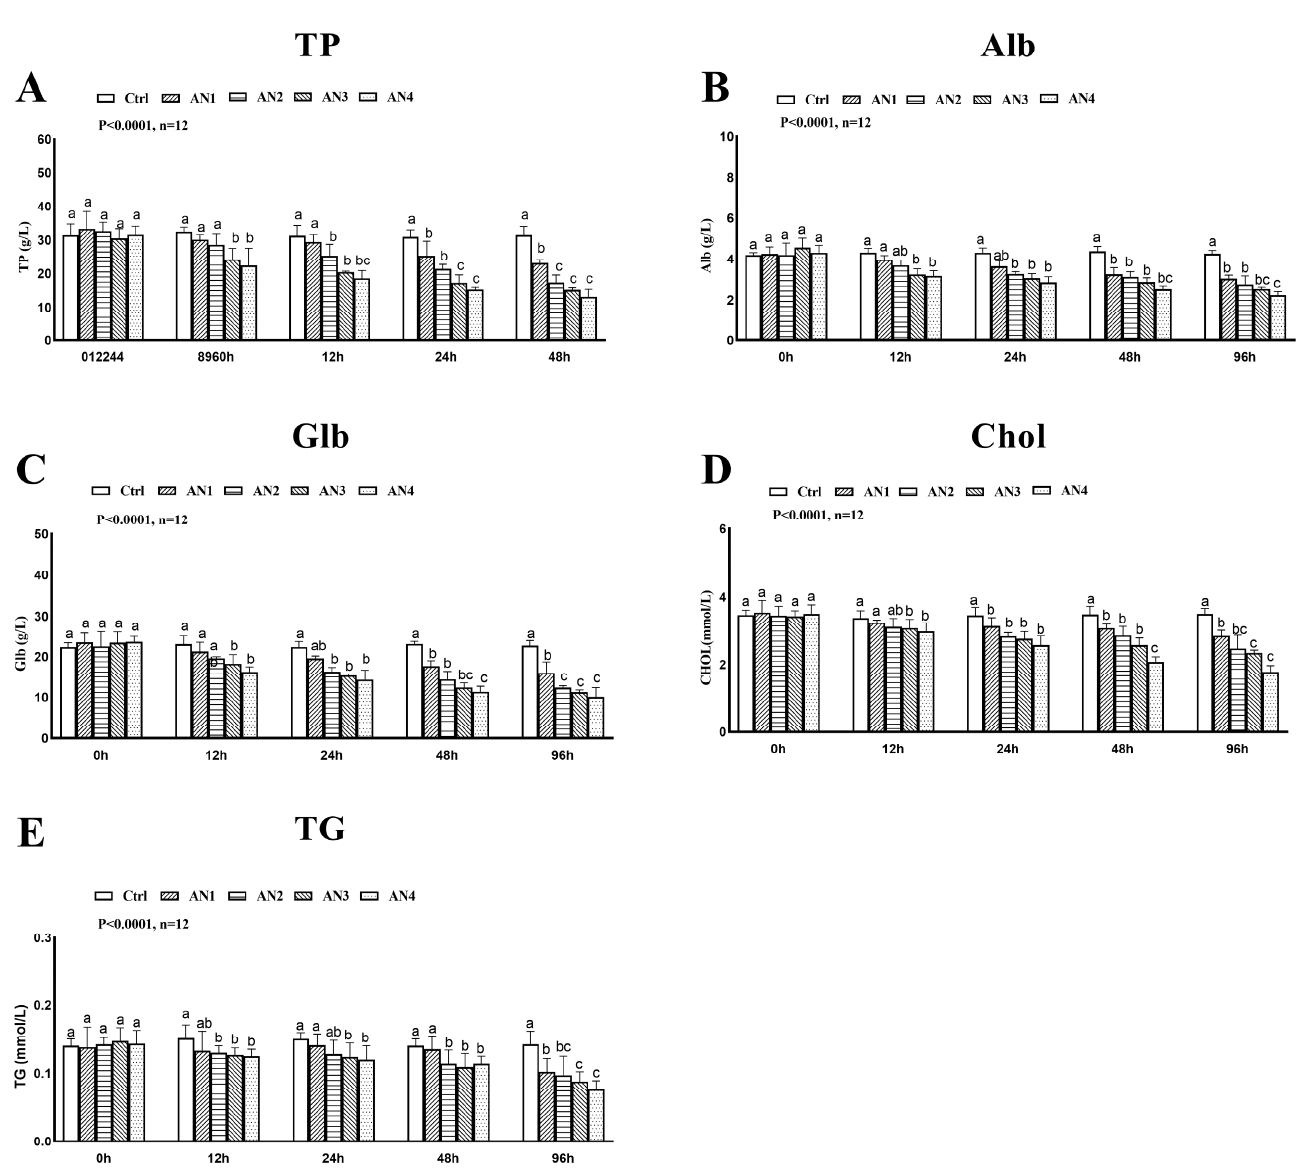
Figure 2. Changes of plasma biochemistry of bighead carp exposed to ammonia. ( A ) Serum total protein (TP), ( B ) albumin (ALB), ( C ) globulin (GLB), ( D ) total cholesterol (CHOL), and ( E ) triglycerides (TG). Values are expressed as mean ± standard error (SE) from triplicate groups ( n = 12). Bars with different letters (a, b, c, differ significantly from those of other groups ( p < 0.05).